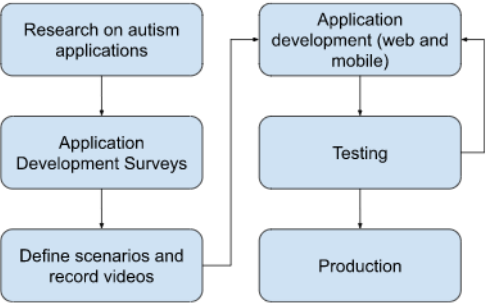
Figure 2. Phases of the development